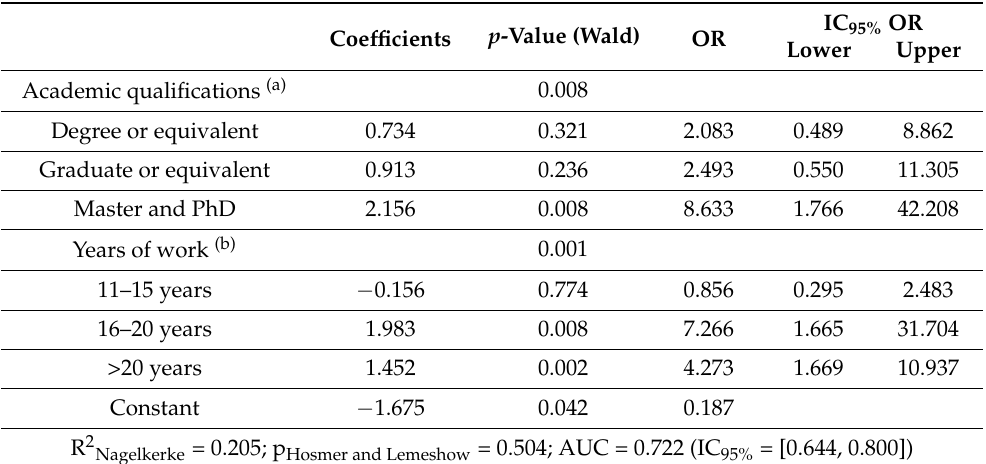
Table 6. Estimated regression coefficients from binary logistic regression analysis, only for significant variables (agree and do not agree).